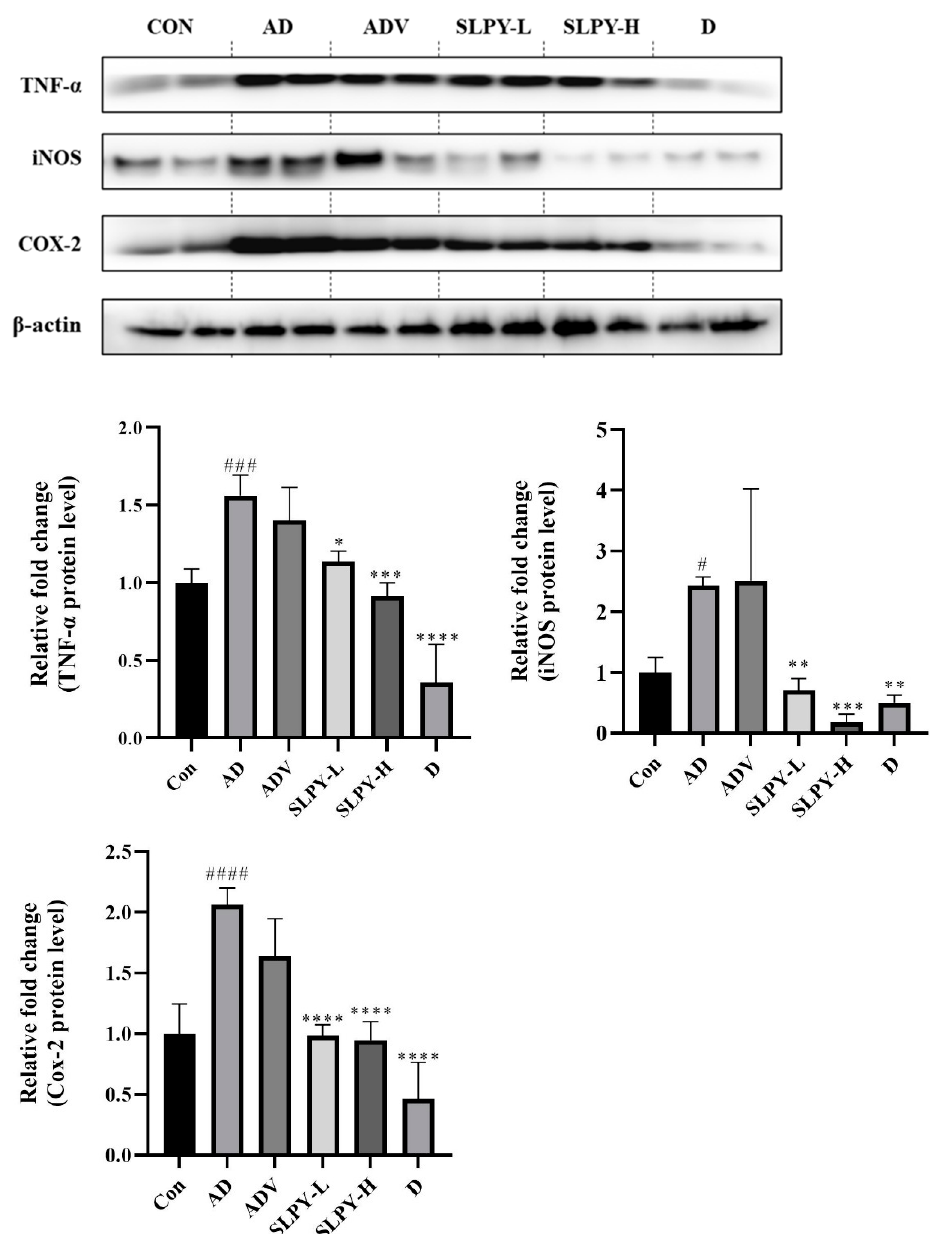
Figure 5. Effect of SLPY on level of inflammatory protein expression in skin tissues of DNCB-treated mice. Mice were challenged with DNCB to induce AD-like skin lesions and tested with SLPY to assess the changes in the levels of inflammation-related protein expression: tumor necrosis factor- α (TNF- α ), cyclooxygenase (Cox-2), and inducible nitric oxide synthase (iNOS). Values represent the mean ± SD of three replicates. #### p < 0.0001, ### p < 0.001, and # p < 0.05 vs. the corresponding control group and **** p < 0.0001, *** p < 0.001, ** p < 0.01, and * p < 0.05, vs. the corresponding AD group. SLPY: steamed and freeze-dried powdered by-product of mature silkworm larva of the Yeonnokjam strain. CON: non-treatment group; AD: 2,4-dinitrochlorobenzene (DNCB)-induced group; ADV: combined treatment of 1% DNCB and vehicle; SLPY-L: combined treatment of 1% DNCB and 50 mg/Kg SLPY; SLPY-H: combined treatment of 1% DNCB and 100 mg/Kg SLPY; D: combined treatment of 1% DNCB and Dermatop (0.25% ( w/w ).